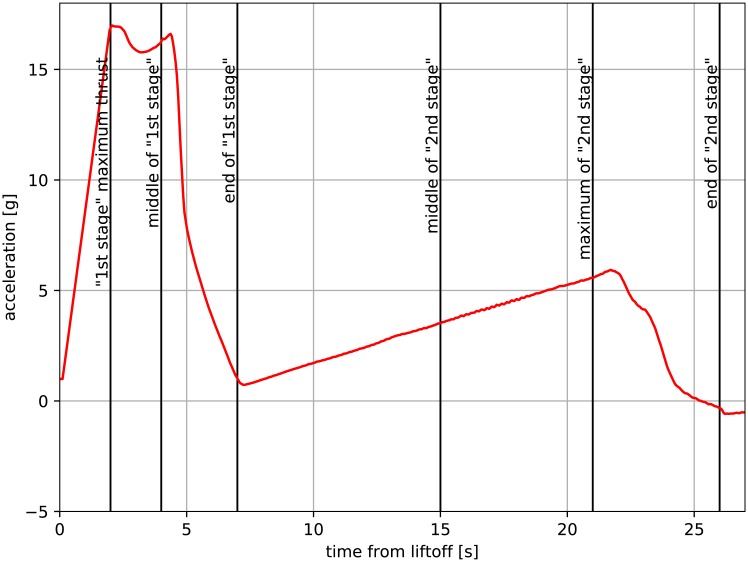
Acceleration of REXUS-18 [17].